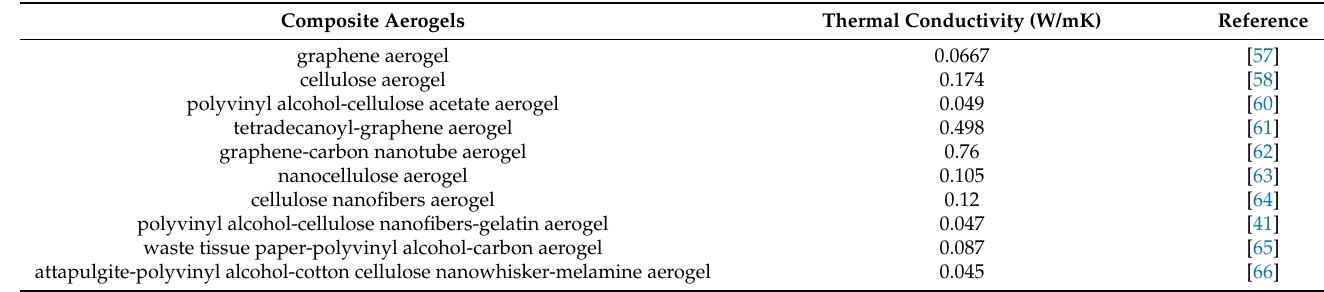
Table 2. Thermal conductivity of CNF composite aerogel, GA composite aerogel and PVA composite